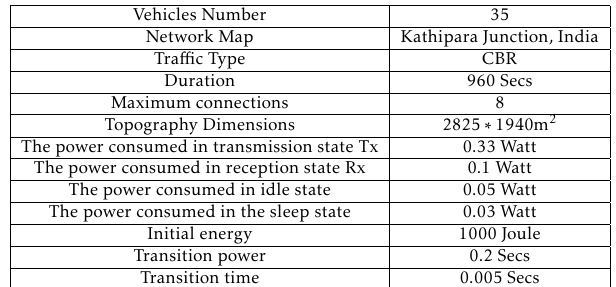
Table 2. VANets Simulation parameters Vehicles